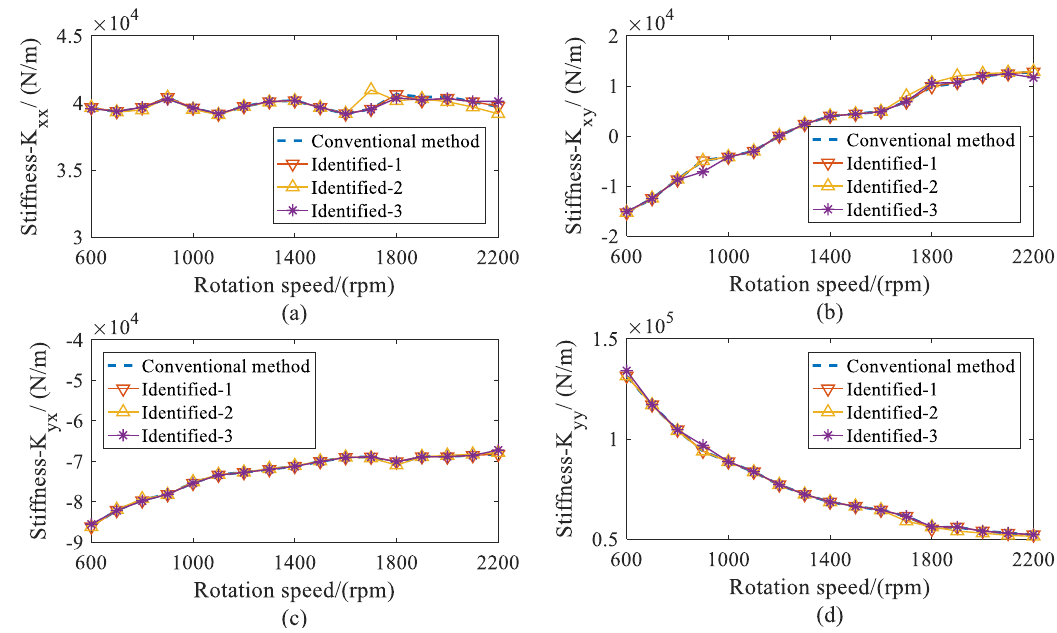
Figure 12. Comparison for stiffness coefficients of bearing 1 versus rotation speed. ( a ) direct stiffness coefficient K xx ; ( b ) cross-coupled stiffness coefficient K xy ; ( c ) cross-coupled stiffness coefficients K yx ; ( d ) direct stiffness coefficients K yy .